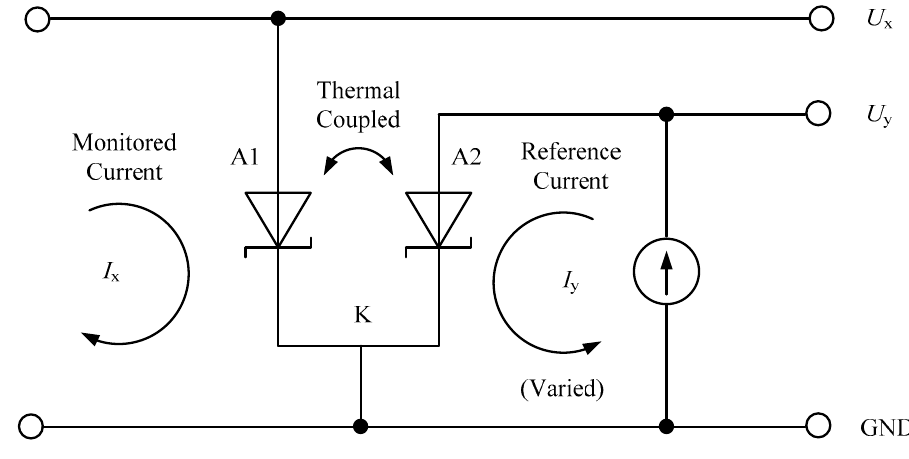
Figure 3. Current measurement method based on twin diode.